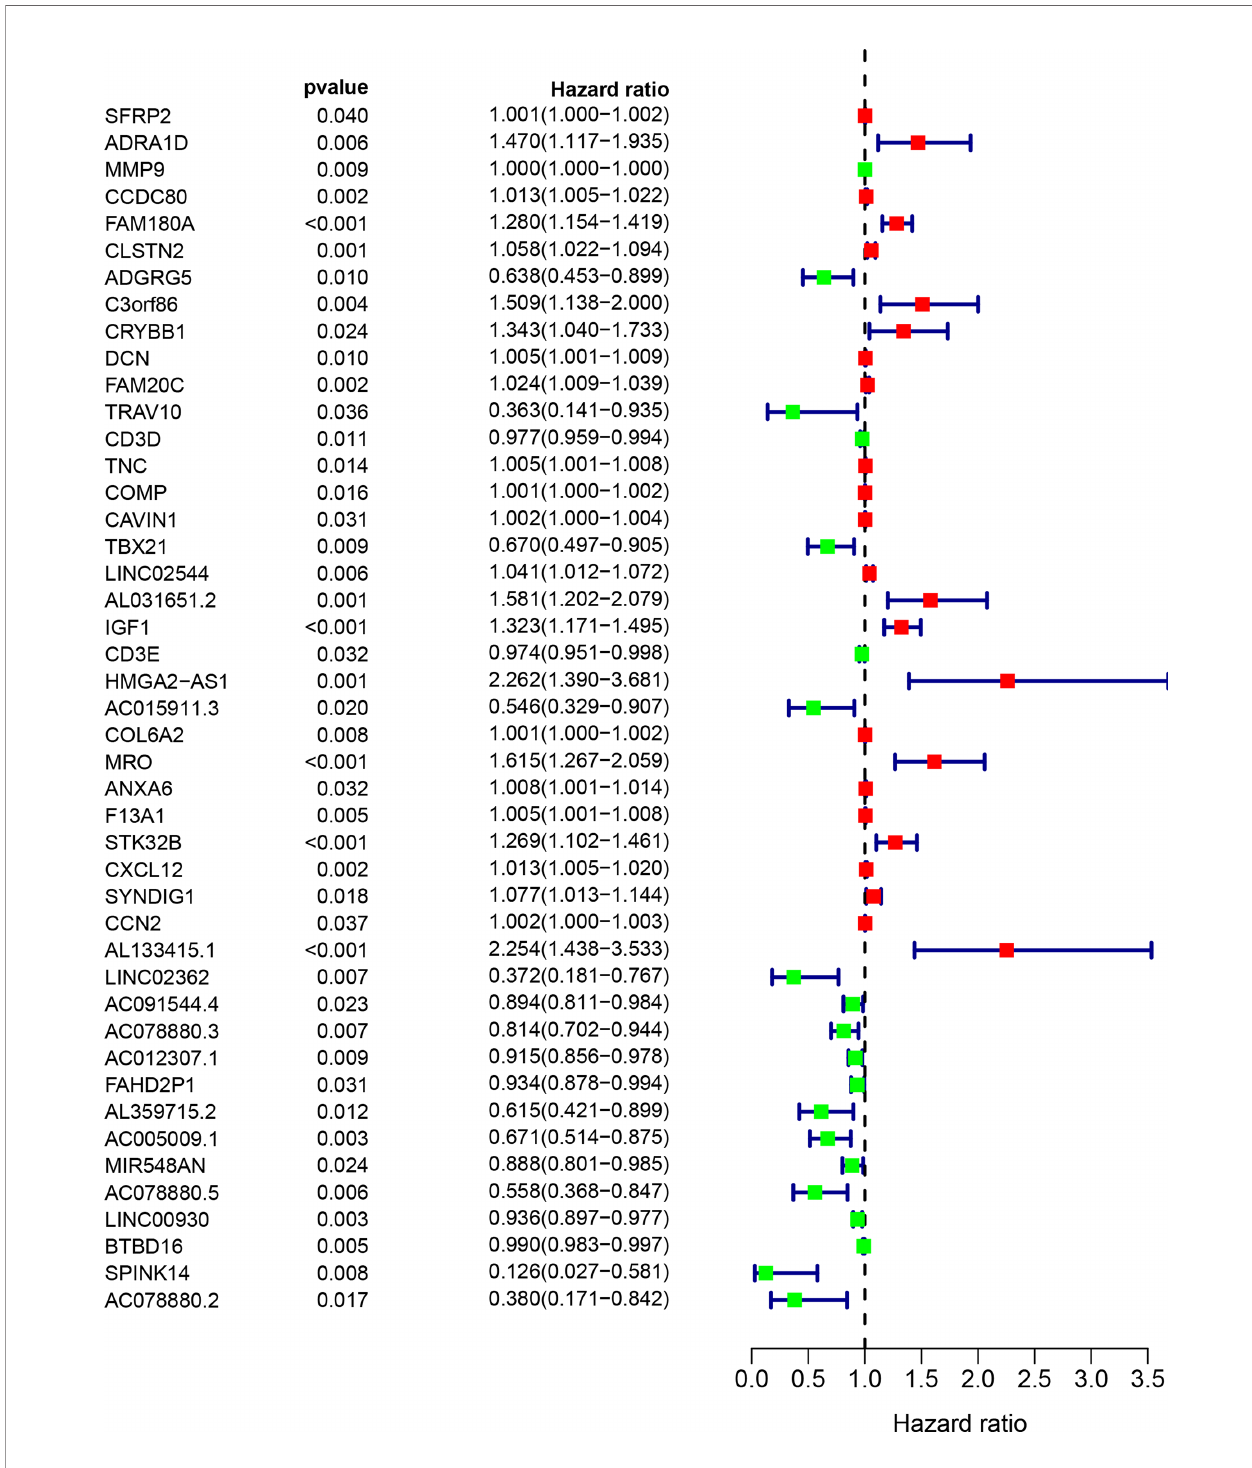
FIGURE 5 | The univariate COX regression analysis of the DEGs. Only 45 DEGs were signi fi cantly correlated with prognosis ( p <